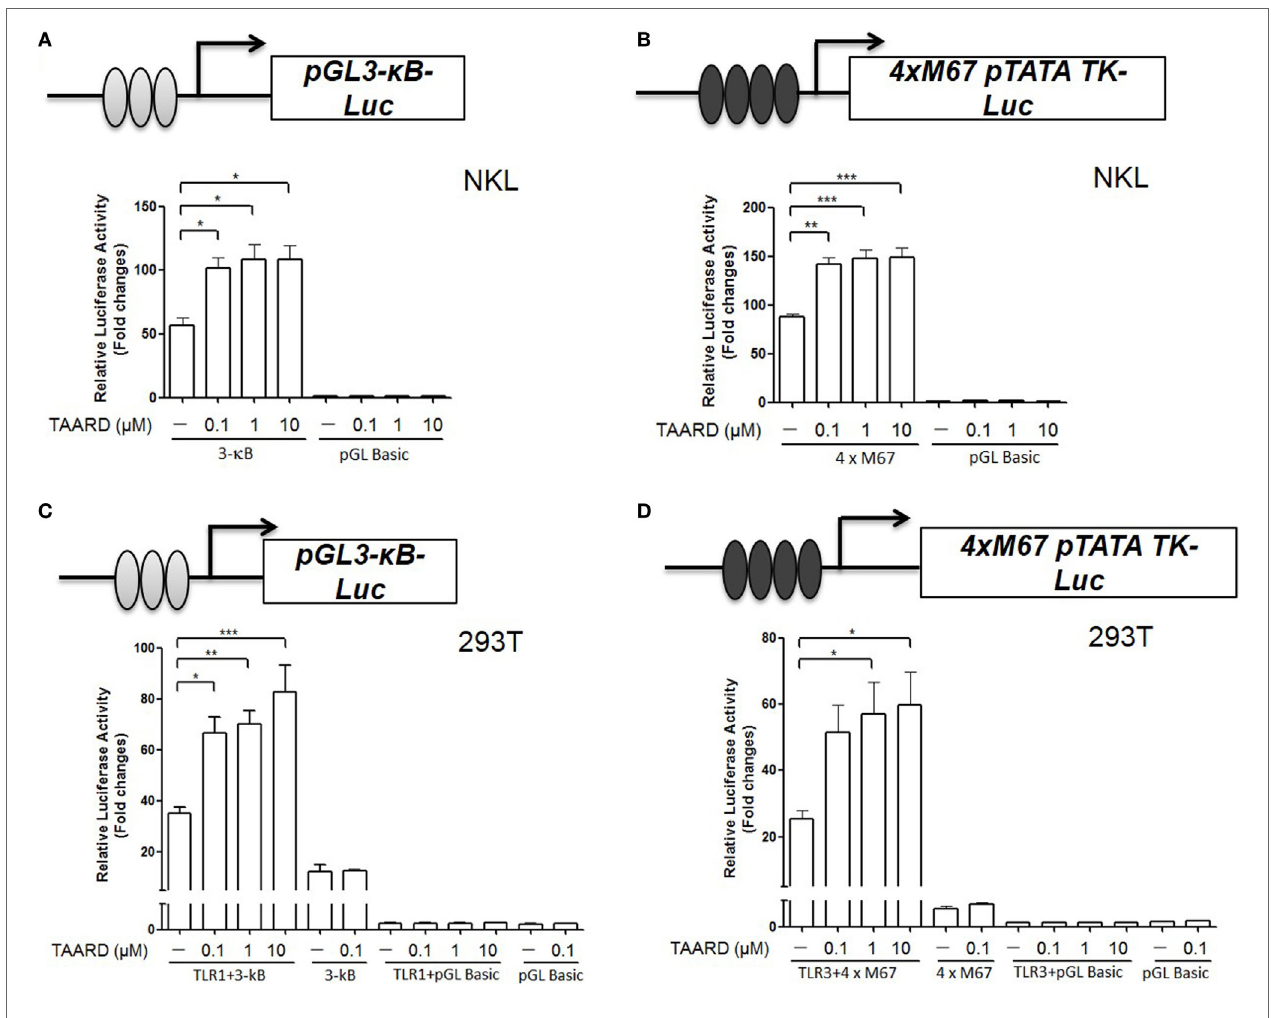
FigUre 4 | TAARD increases the luciferase reporter activities of NF- κ B and STAT3 via TLR1 and TLR3, respectively. (a) NKL cells were electroporated with either pGL3- κ B-Luc (1 µg) or pGL3-Basic (1 µg) and a pRL-TK renilla-luciferase control plasmid (50 ng). After electroporation, cells were immediately transferred into fresh medium and cultured for an additional 6 h. Then, cells were treated with different concentrations of TAARD. (B) NKL cells were electroporated as described